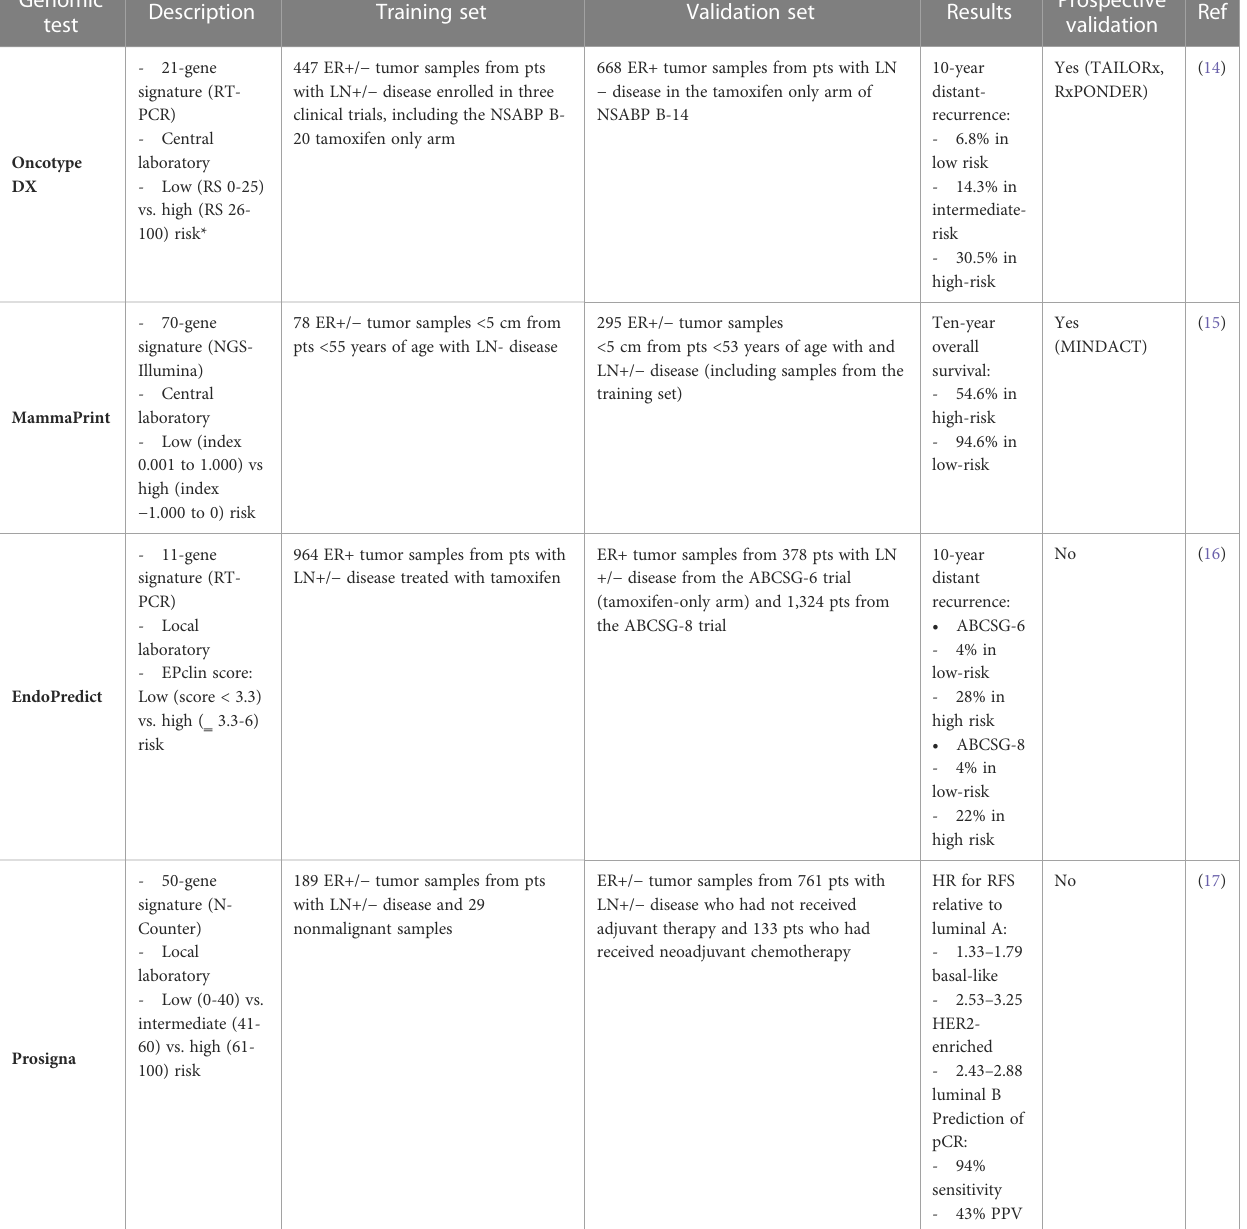
TABLE 1 Available Genomic Assays for ER+/HER2- Early Breast Cancer in Italy. Genomic